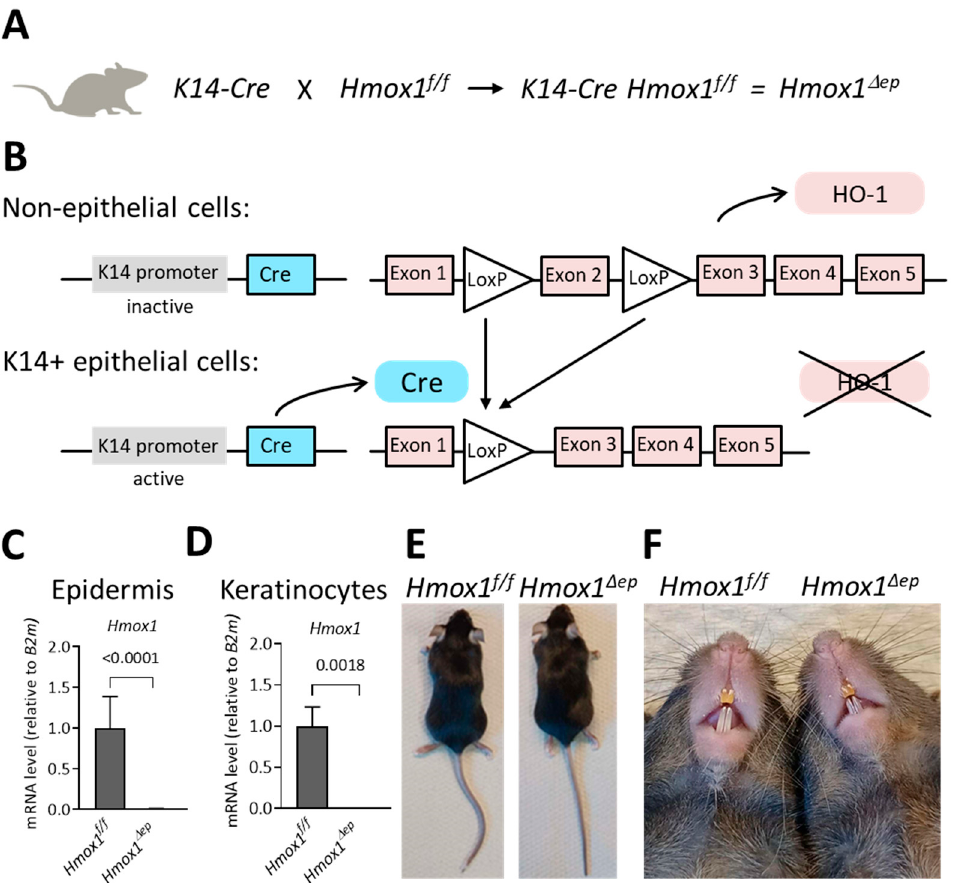
Figure 4. Epithelial deletion of heme oxygenase-1 ( Hmox1 ). ( A ) Hmox1 ∆ ep mice were generated by crossing K14-Cre and Hmox1 f/f mice. ( B ) Schematic depiction of Cre-mediated recombination in K14-positive epithelial cells, leading to the deletion of Hmox1 exon 2 and subsequent loss of HO-1 expression. RT-qPCR analysis of Hmox1 mRNA levels in the epidermis ( C ) and isolated keratinocytes ( D ) of control ( Hmox1 f/f ) and epithelial Hmox1 -deleted ( Hmox1 Δ ep ) mice. The mRNA levels are normalized to the mRNA levels of B2m in the same samples. p -values ( t -test) are indicated above the horizontal bars. ( E ) Macroscopic appearance of Hmox1 f/f and Hmox1 Δ ep mice at an age of 3 months. Neither male ( n > 10) nor female ( n > 10) mice displayed phenotypic abnormalities. ( F ) Ventral view of Hmox1 f/f and Hmox1 Δ ep snout skin and teeth of mice at an age of 3 months. Note the absence of scaling or signs of skin inflammation. The yellow color of upper incisors indicates normal secretion of iron into the enamel.